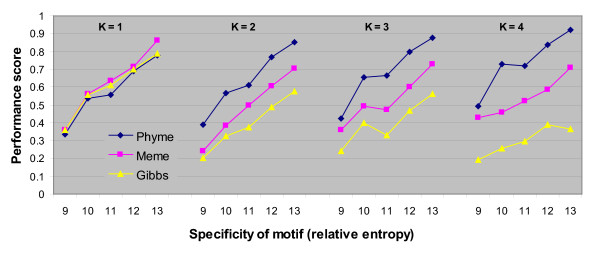
Effect of varying the number of species (K) on motif-finding performance. The x-axis is the relative entropy (R) of the planted motif. Each point is an average over 10 experiments with synthetic data. (μb = 0.3, μm = 0.1.)